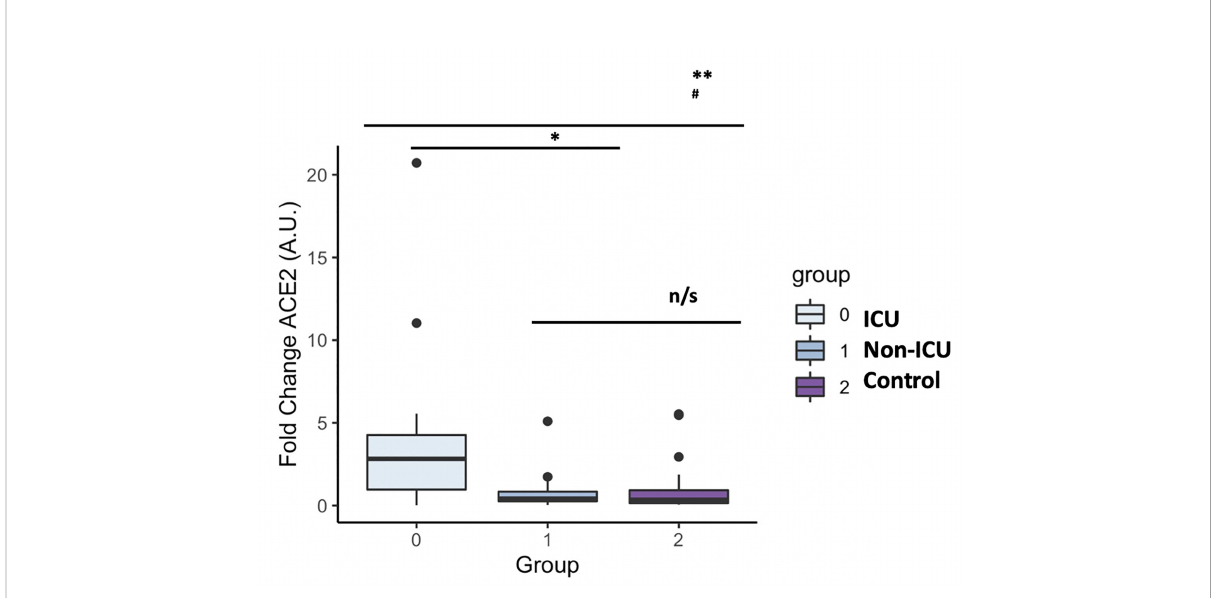
FIGURE 5 ACE2 mRNA levels in COVID-19 patients and the uninfected control group. The box plots represent the maximum and minimum levels (whiskers), the upper and lower quartiles, and the median. The length of each box represents the interquartile range. Dots represent outliers. Statistical signi fi cance between groups was determined using the ANOVA test. **p <0.001, # p <0.001 UCI vs Control, n/s (non signi fi cant); ACE2 (angiotensin-converting enzyme